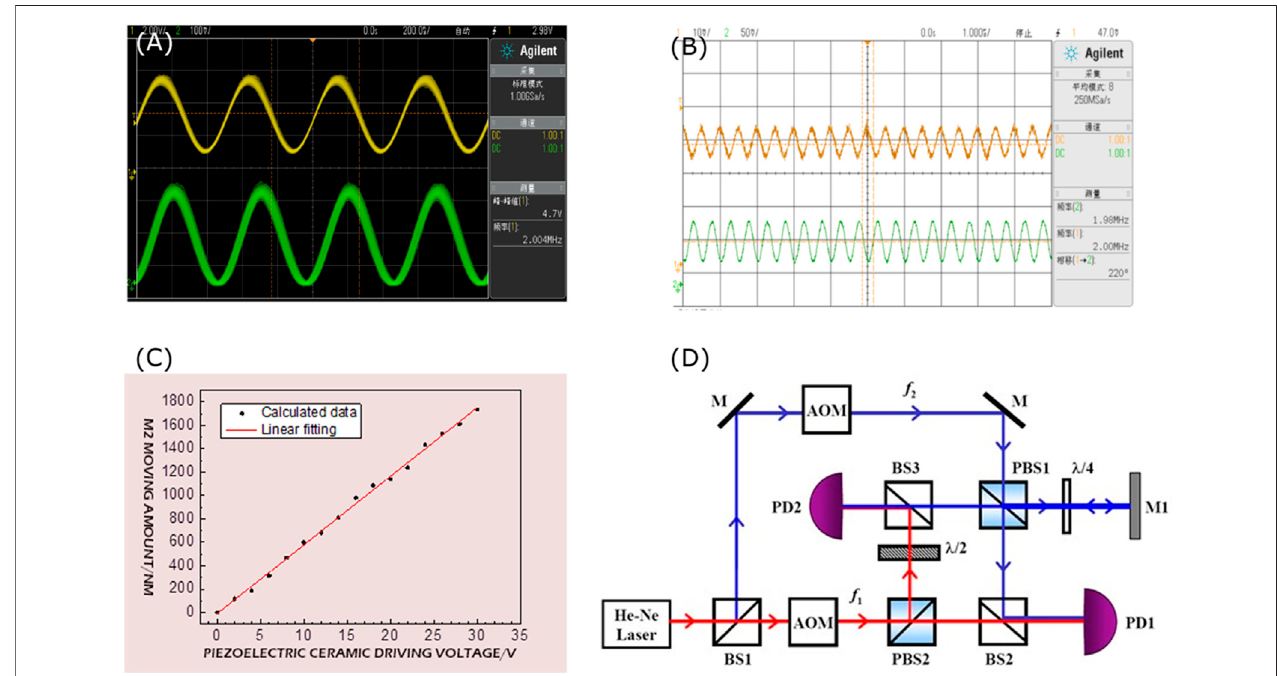
FIGURE3|(A) Measurementresultsfromreal-time sampling,and (B) measurementsaftereight averaging. (C) Therelationshipbetweentheamountofmovement of the mirror M2 and the voltage. (D) Optical path of polarization dual-frequency laser interference system. PBS: Polarization beam splitter, λ /2: half-wave plate, λ /4: quarter-wave plate.